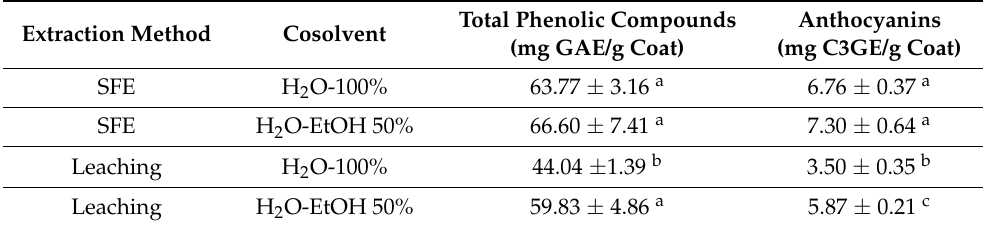
Table 1. Total phenolic compounds and anthocyanins extracts obtained by SFE and leaching process. Extraction